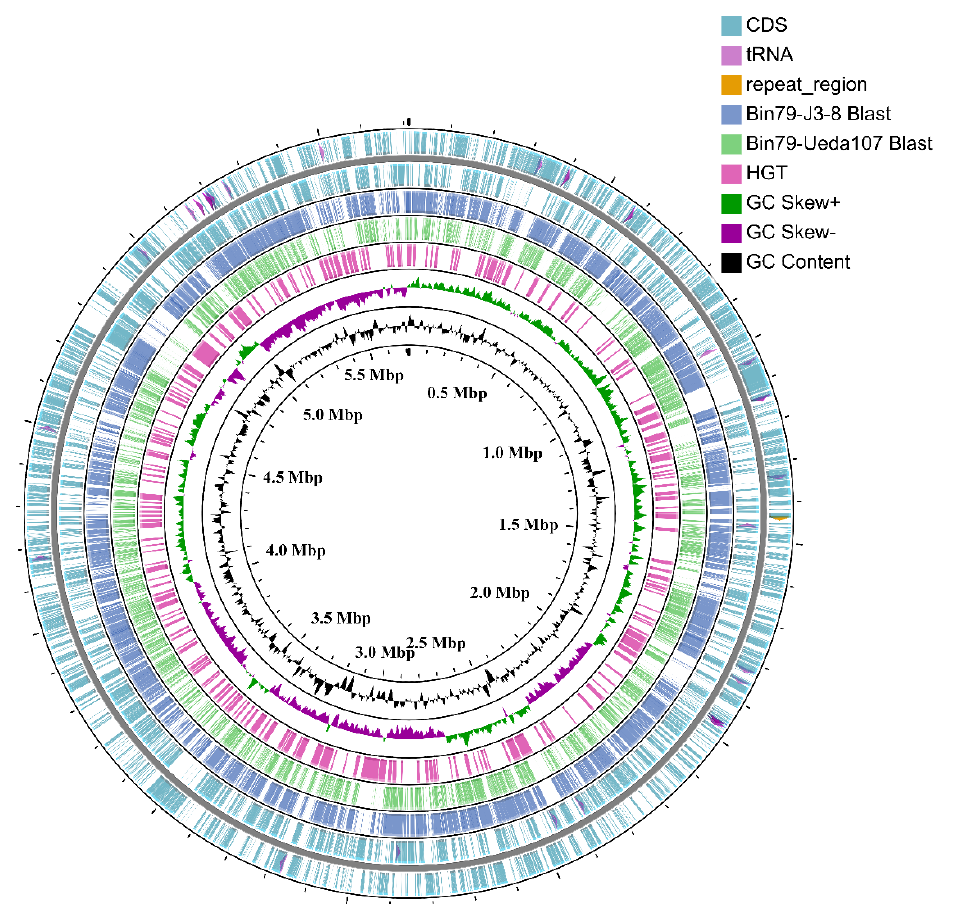
Figure 1. Circular representation of the Cellvibrio sp. Bin79 genome. The contents of the feature rings (starting with the outermost ring) are as follows: Ring 1 and Ring 2, features from the forward and reverse strands, respectively, CDSs are drawn as arcs, and tRNAs and repeat regions are drawn as arrows; Ring 3 ( Cellvibrio mixtus subsp. mixtus J3-8) and Ring 4 ( Cellvibrio japonicus Ueda107) show BLAST comparison results (BLASTN, E-value 1e − 20) with the Bin79 genome, the BLAST comparison results are drawn with partial opacity, and darker regions indicate that multiple hits to the corresponding sequence region were observed; Ring 5 shows the genomic regions acquired via horizontal gene transfer; Ring 6 shows GC skew; and Ring 7 shows GC content. The plot was drawn using the CGview server [23]. 3.3. Gene Expression Comparison of Bin79 between the Rhizosphere and Rhizoplane Table 1. Features of the Cellvibrio sp. Bin79 genome.